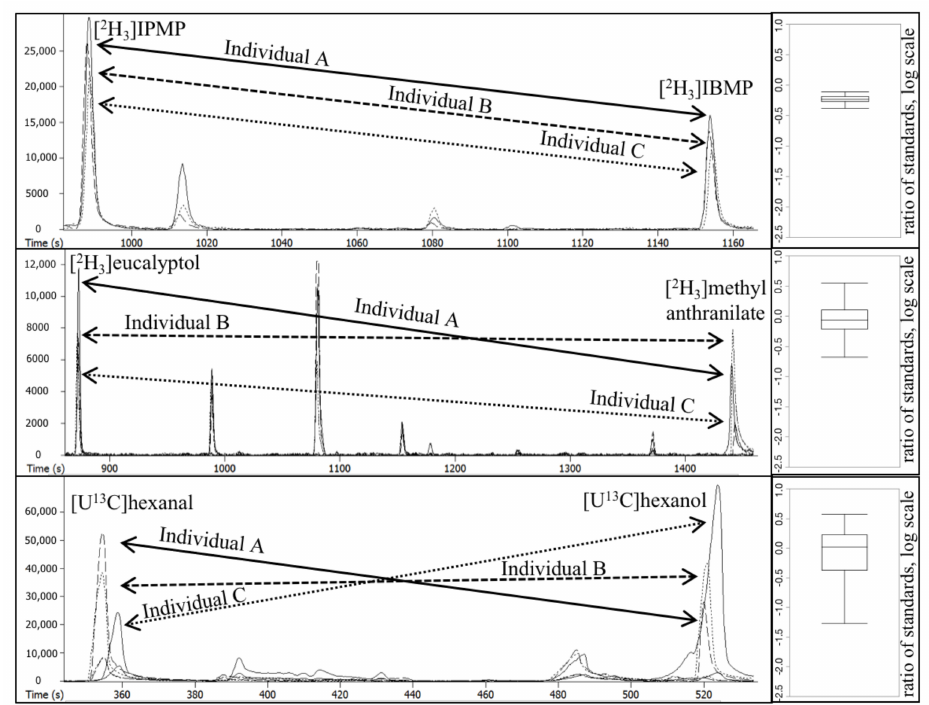
Figure 2. Chromatograms (left) and corresponding box plots (right) of Compound × Individual matrix effects for three pairs of internal standards in three different grape individuals (A, B, C). Internal standards are [2H3]IBMP and [2H3]IPMP (top), [2H3]eucalyptol and [2H3]methyl anthranilate (middle), and [U 13 C]hexanal and [U 13 C]hexanol